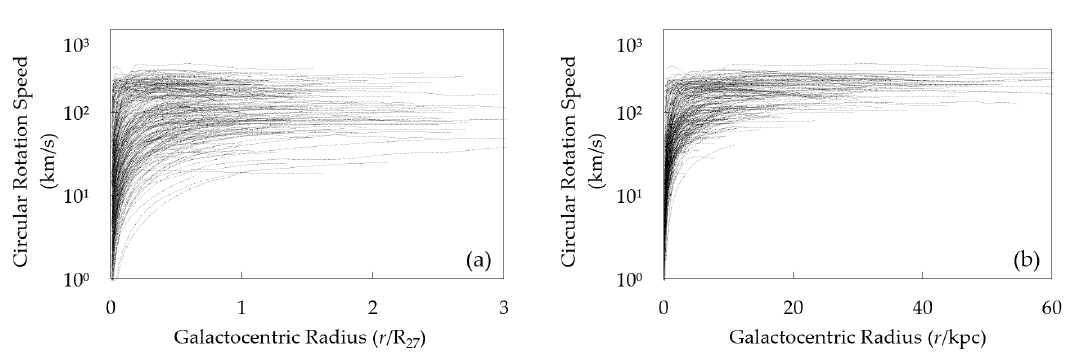
Figure 6. Superimposed 214 rotation curves: ( a ) Plotted against radii expressed in r / R 27 units; ( b ) plotted against radii expressed in r / kpc units. The Y-axis log scale shows rotation speed in km /